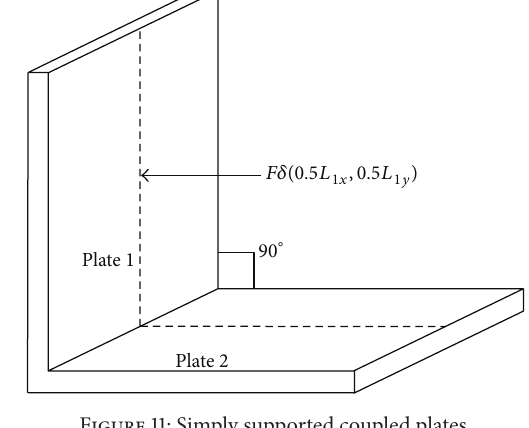
Figure 11: Simply supported coupled plates. Table 4: Parameters for each